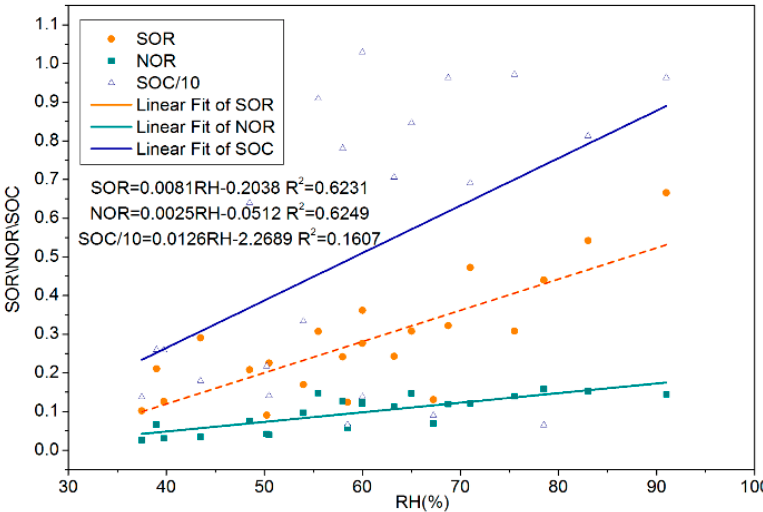
Figure 3. Linear regression analysis between Sulfur Oxidation Rate (SOR), Nitrogen Oxidation Rate (NOR), Secondary Organic Carbon (SOC), and Relative Humidity (RH) during the heating season in 2016.